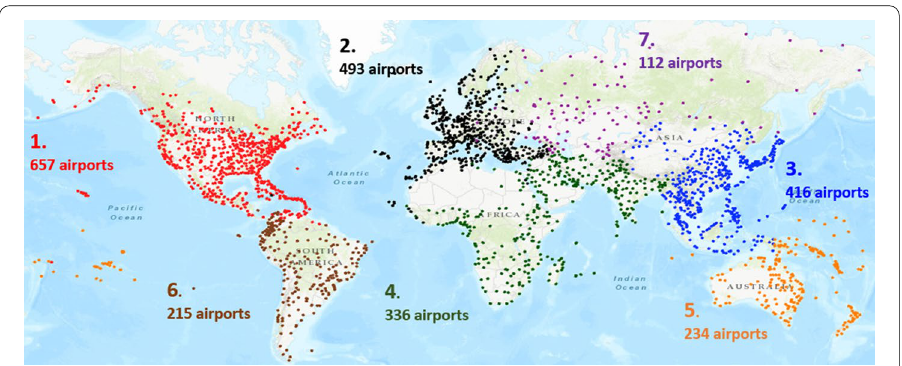
Fig. 5 The seven large local components. ( 1 ) Airports in the North and Central America-Caribbean are in red. ( 2 ) Airports in the European component are in black. ( 3 ) Airports in the East and Southeast Asia component are in blue. ( 4 ) Airports in the Africa-Middle East and India component are in green. ( 5 ) Airports in the Oceania component are in orange. ( 6 ) Airports in the South America component are in brown. ( 7 ) Airports in the Russia-Central-Asia-Transcaucasia component are in